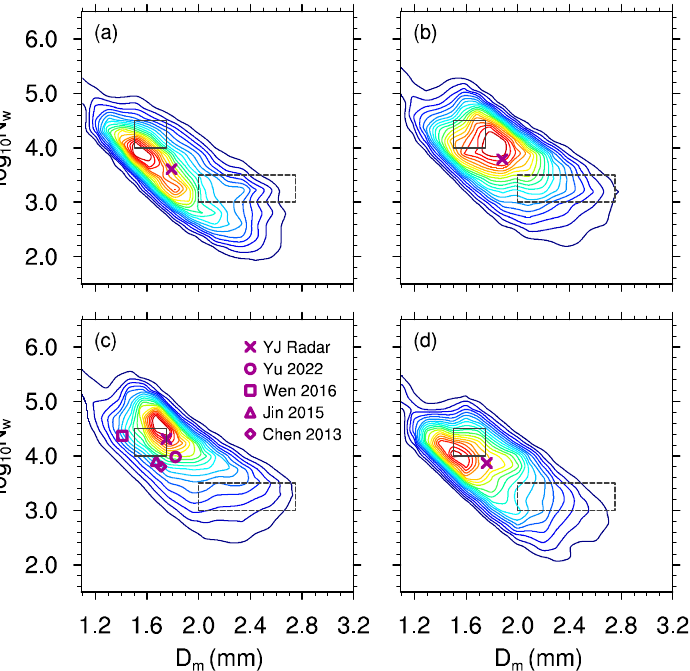
Figure 11. Frequency of the occurrence of D m (mm) and log 10 N w (units of N w : mm − 1 m − 3 ) of the retrieved RSDs under 2 km from the YJ S-POL data of convective precipitation over Jinjiang at the four stages: ( a ) initial (S1), ( b ) developing (S2), ( c ) mature (S3), and ( d ) dissipating (S4). The outermost line represents the 5% contours; the contour ranges from 5% to 100% with an interval of 5%. The mean values of D m and log 10 N w in the present study are distinguished by different symbols as demonstrated by the legends, with the average values being marked in magenta. The gray solid border and the dotted border are the oceanic and continental convective areas defined by Bringi et al.